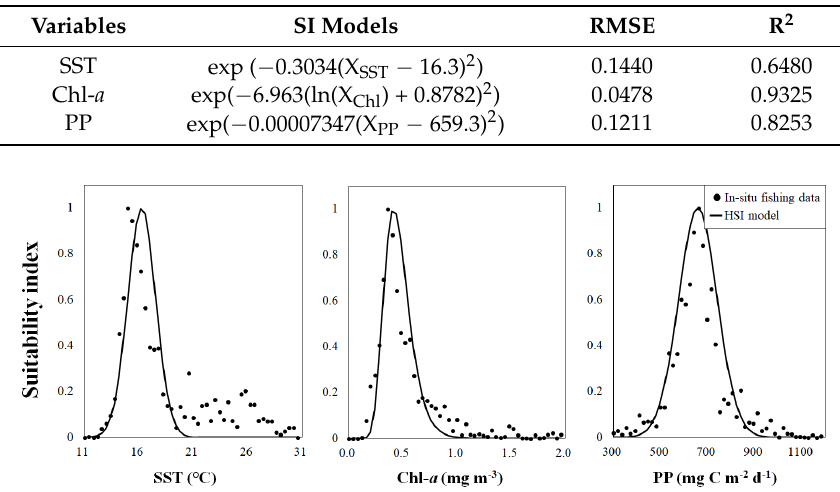
Figure 5. Least squares fitting results of ( a ) SST (°C), ( b ) Chl- a (mg m − 3 ), and ( c ) PP (mg C m − 2 d − 1 ) with the number of fishing sets (solid line: habitat suitability index (HSI) model, black dot: in situ fishing data). The RMSE of the SI models for SST, Chl- a , and PP were 0.1440, 0.0478, and 0.1211, respectively. The coefficients of determination ( R 2 ) for the SI models were 0.65, 0.93, and 0.83 for SST, Chl- a , and PP, respectively.